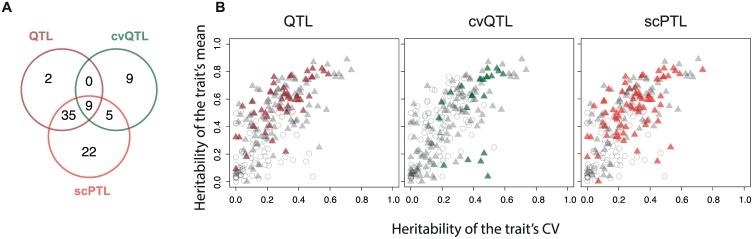
Complementarity of scPTL and QTL mapping using experimental data.The data of Nogami et al. [22] was used to perform genomic scans for QTL, cvQTL and scPTL. For scPTL mapping, we used both the first-axis only and multiple dimensions of the phenotypic space (see methods), and the results were pooled. A) Venn diagram showing the number of traits for which a significant locus was found in the genome by each method (each at FDR = 10%). B) Same representation as Fig 2B showing the traits successfully mapped by each method. The traits that passed the heritability filter (see methods) and were considered for mapping are shown as triangles, and colored if mapping was successful.